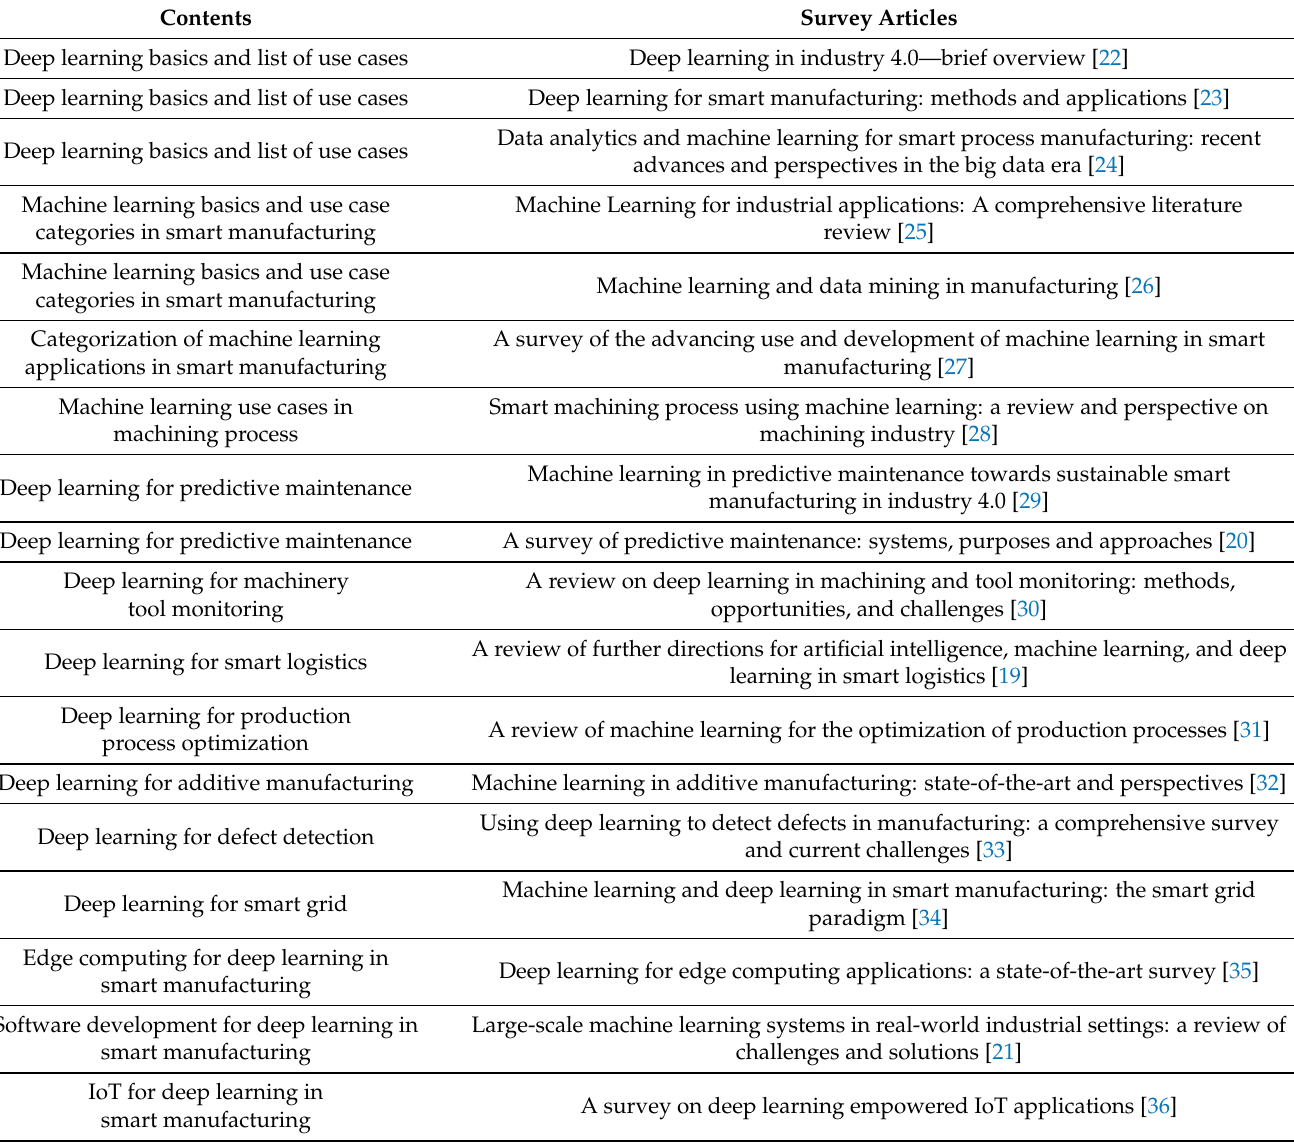
Table 1. List of review articles we can find in the literature on deep learning in smart